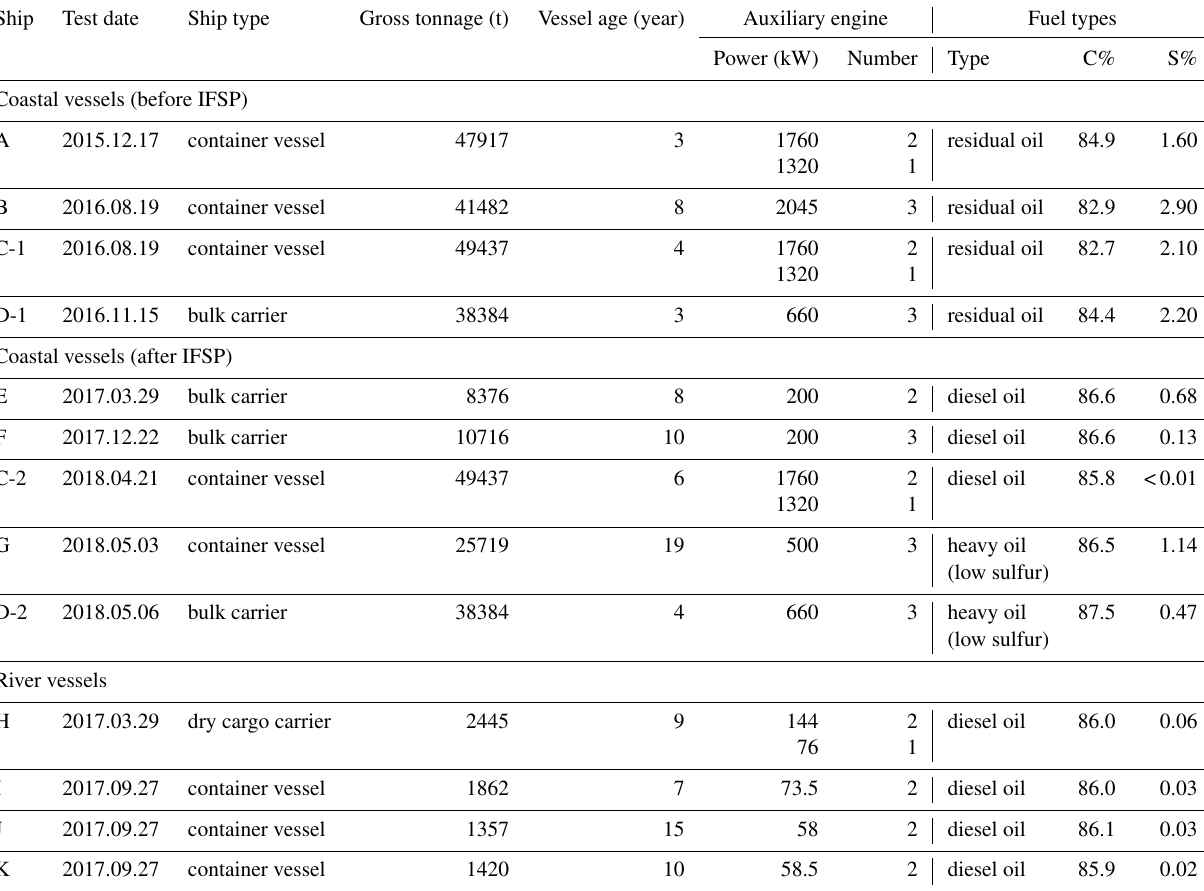
Table 1. The basic information of test